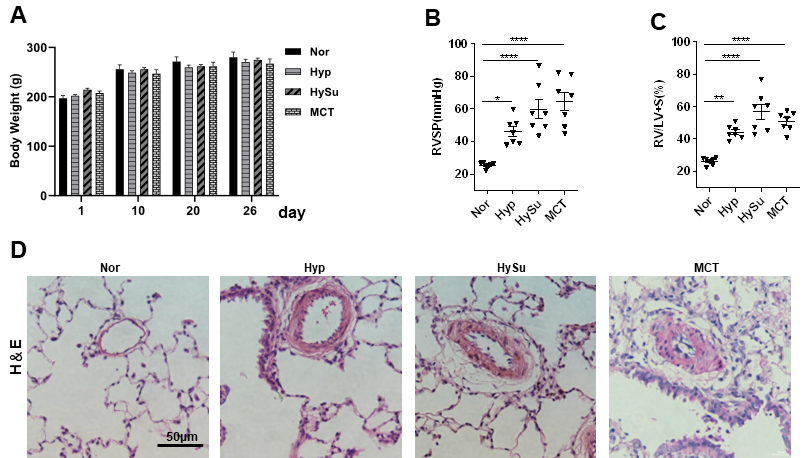
Figure 1. Hyp-, HySu-, and MCT-induced PH in rats. ( A ) The body weight of rats was measured at the indicated time points ( n = 5–7). ( B , C ) RVSP and RV/LV+S ratio, respectively, in three PH rat models. Data are presented as the mean ± SEM. For multiple comparisons, one-way ANOVA (analysis of variance) for normally distributed samples followed by the Tukey HDS (honestly significant difference) method. (* p < 0.05, ** p < 0.01, **** p < 0.0001, n = 7). ( D ) Representative hematoxylin and eosin-stained lung sections in three PH rat models. Scale bars: 50 µ m. Nor: normoxia group; Hyp: hypoxia-induced group; HySu: hypoxia/Sugen5416-induced group; MCT: MCT-induced group. 0, 2, and 4 represent the week of treatment; Filled triangle represent the rat individual in ( B